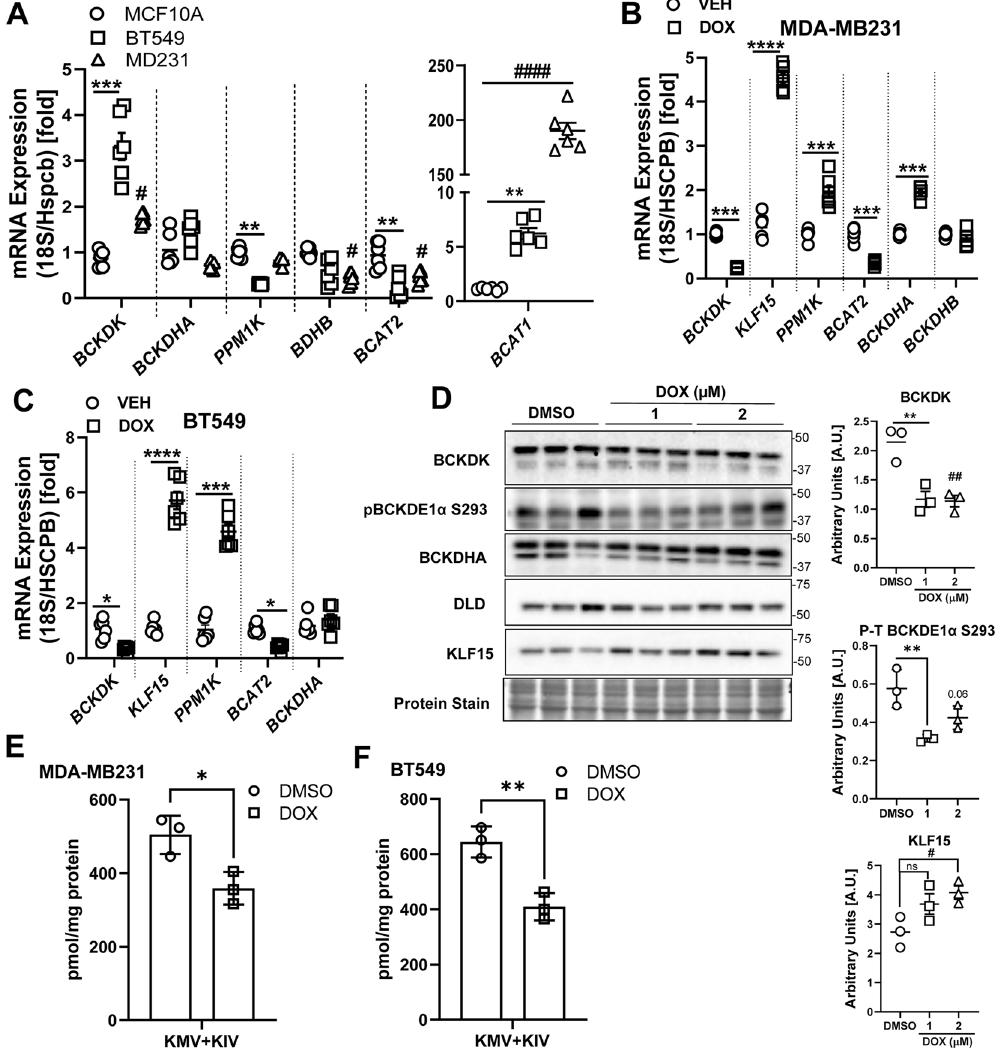
Fig. 1 DOX suppresses BCKDK expression and augments BCAA oxidation enzyme expression in TNBCs. A Quanti fi cation of BCKDK , BCKDHA , PPM1K , BCKDHB , BCAT2 , and BCAT1 mRNA expression corrected to 18S/HSPCB reference genes in MCF10A, BT549, and MDA-MB231 cells. B , C BCAA catabolic enzyme expression in TNBCs treated with 2 µM DOX for 18 h. Quanti fi cation of BCKDK , BCKDHA , PPM1K , BCKDHB , BCAT2 , and KLF15 mRNA expression corrected to 18S/HSPCB reference genes in MDA-MB231 ( B ) and BT549 ( C ) cells. D Immunoblot and densitometric analysis of BCKDK, total and phosphorylated BCKDHA E1 α Ser 293, DLD and KLF15 in MDA-MB231 cells treated with 1 and 2 µM DOX for 18 h. Quanti fi cations are from three independent experiments. Statistical analysis was performed using a two-way ANOVA followed by a Tukey ’ s multiple comparison test; * p < 0.05, ** p < 0.01, **** p < 0.0001 as indicated. *MCF10A vs. BT549 or DMSO vs. 1 µM DOX, #MCF10A vs. MDA- MB231 or DMSO vs. 2 µM DOX. E , F UPLC MS/MS analysis of intracellular BCKAs in E MDA-MB231 and F BT549 cells. All data are presented as mean ± S.D. Statistical analysis was performed using a Student ’ s t test; * p < 0.05, ** p < 0.01, **** p < 0.0001 as